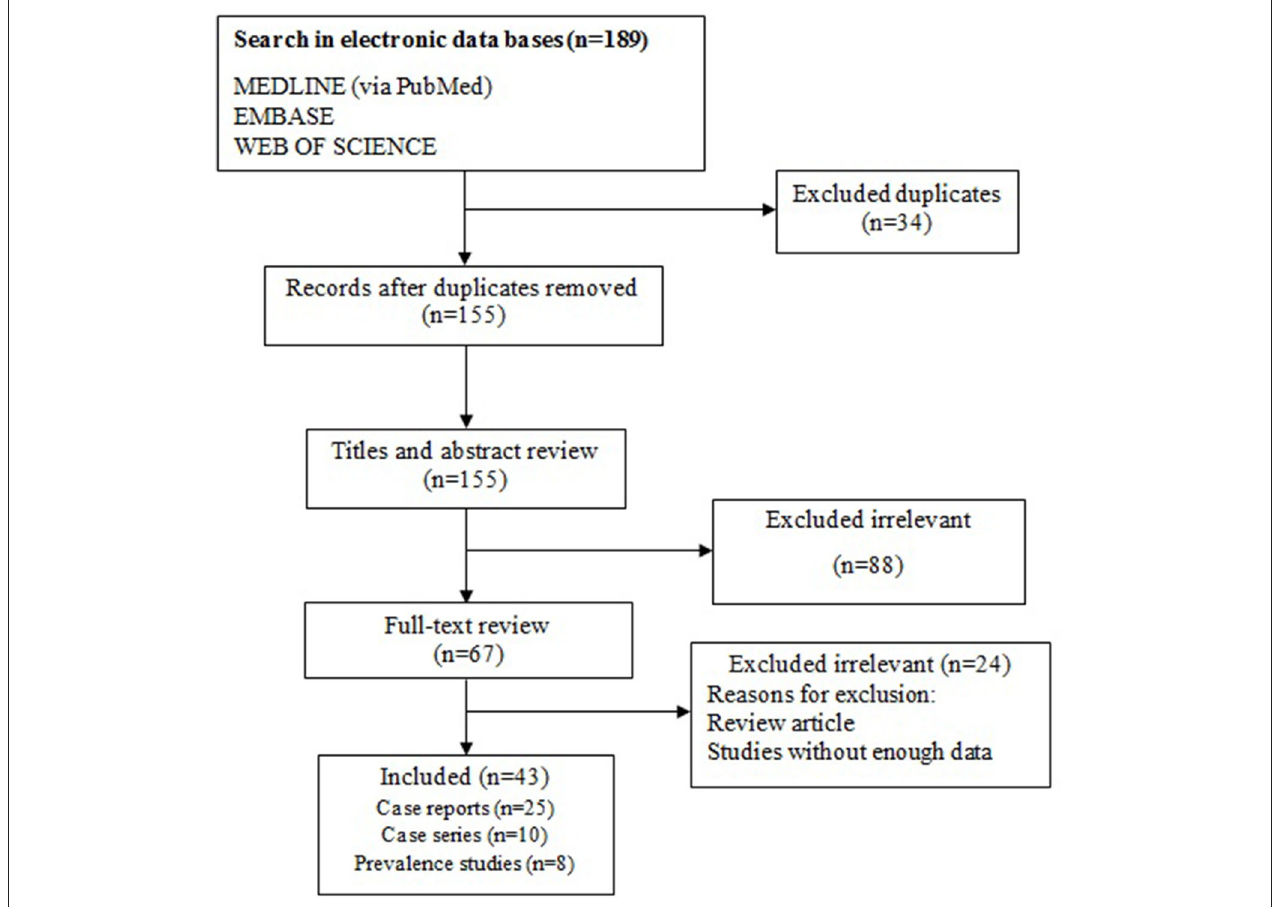
FIGURE 1 | Flow chart of study selection for inclusion in the systematic review.